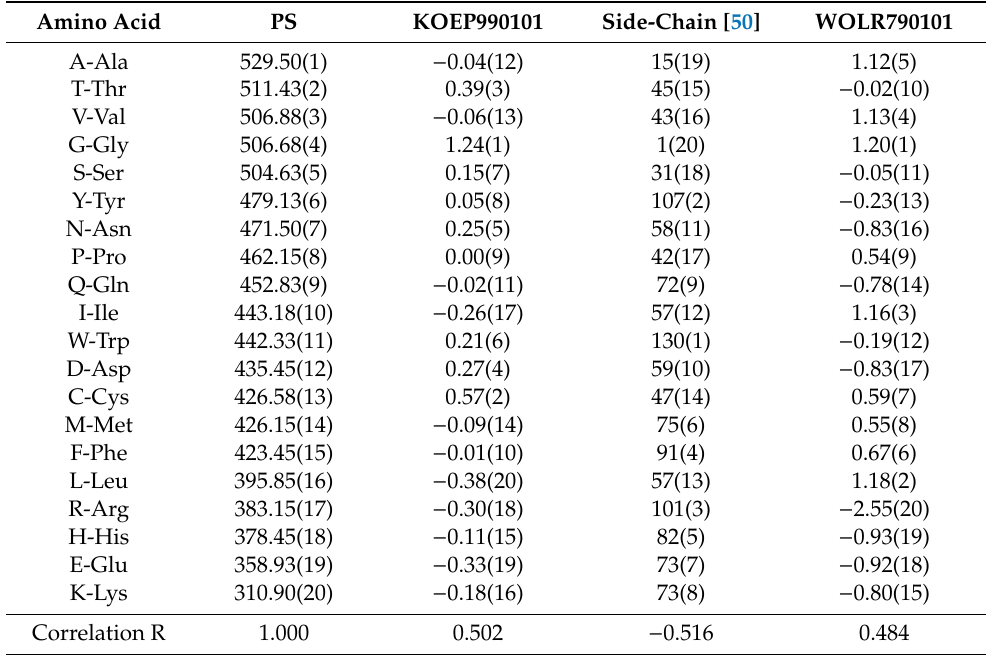
Table 8. The three important physicochemical properties (PCPs) derived from PVPred-SCM. Amino